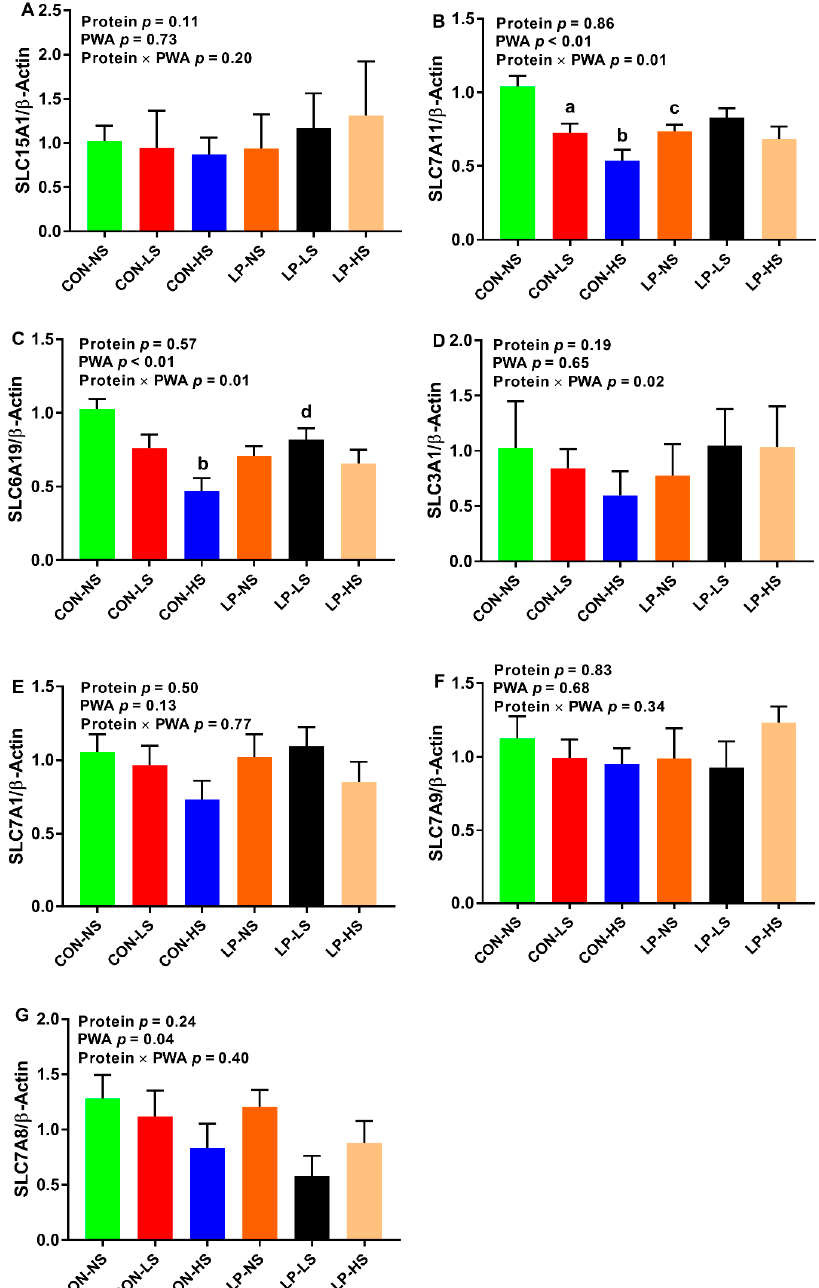
Figure 3. Relative mRNA abundance of ( A ) solute carrier family 15 member 1 ( SLC15A1 ), ( B ) solute carrier family 7 member 11 ( SLC7A11 ), ( C ) solute carrier family 6 member 19 ( SLC6A19 ), ( D ) solute carrier family 3 member 1 ( SLC3A1 ), ( E ) solute carrier family 7, member 1 ( SLC7A1 ), ( F ) solute carrier family 7 member 9 ( SLC7A9 ), and ( G ) solute carrier family 7 member 8 ( SLC7A8 ) in the jejunum of nursery pigs fed with two levels of dietary protein and three levels of a phytogenic water additive (PWA). CON-NS: control diet with no PWA supplemented, CON-LS: control diet with a low dose of PWA (4 mL/L of water) supplemented, CON-HS: control diet with a high dose of PWA (8 mL/L of water) supplemented, LP-NS: low-protein diet with no PWA added, LP-LS: low-protein diet with a low dose of PWA (4 mL/L of water) added and LP-HS: low-protein diet with a high dose of PWA (8 mL/L of water) added. a p ≤ 0.05 CON-NS vs. CON-LS, b p ≤ 0.05 CON-NS vs. CON-HS, each dietary